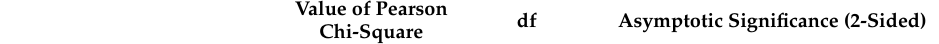
Table 7. The results for chi-square bivariate test for group of comparison US/rest of the world. Value of Pearson df Asymptotic Significance Chi-Square